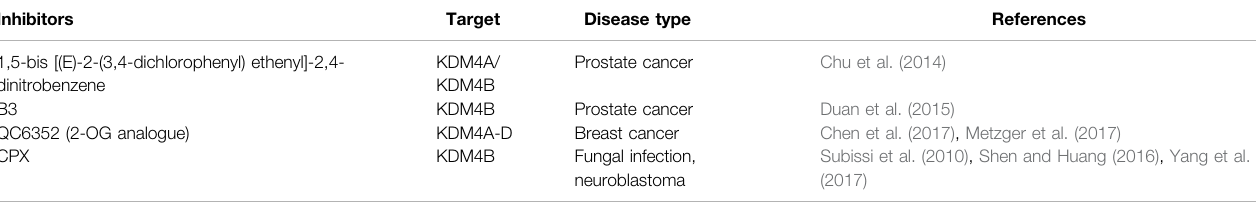
TABLE 1 | Application of KDM4B related inhibitors in various diseases.